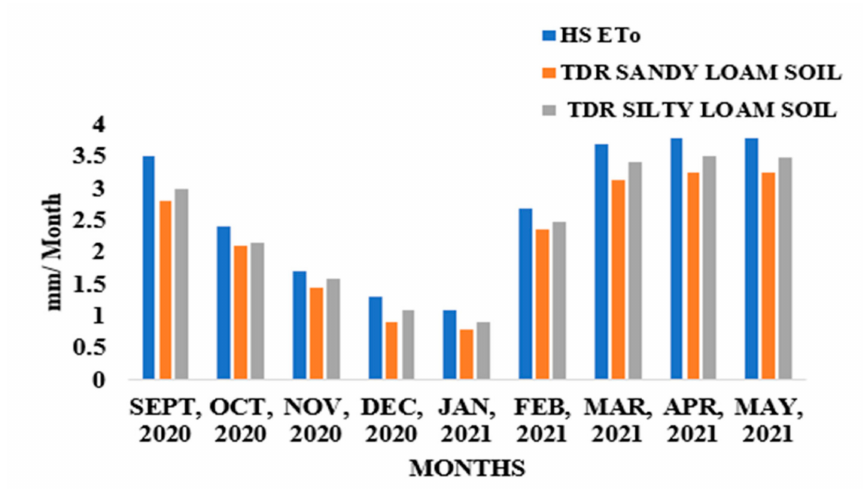
Figure 3. The Hargreaves–Samani model and time-domain reflectometry (TDR)-based estimates